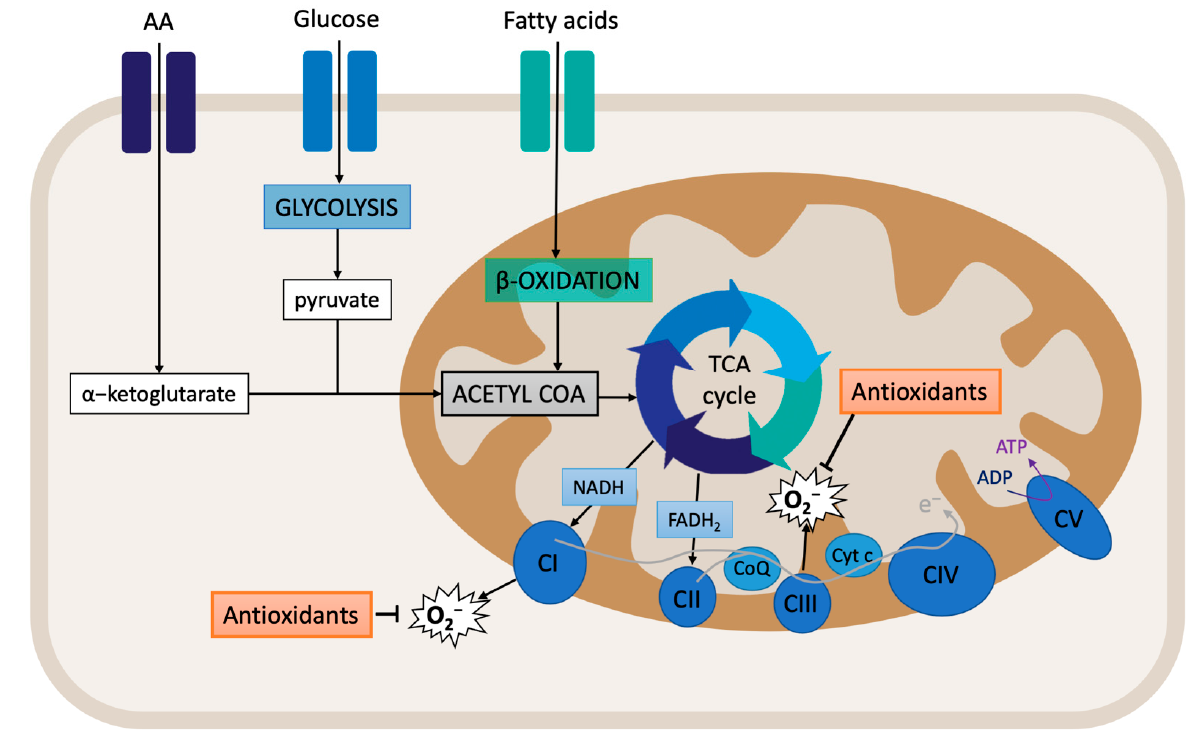
Figure 2. Overview of mitochondrial respiration: oxidative phosphorylation.